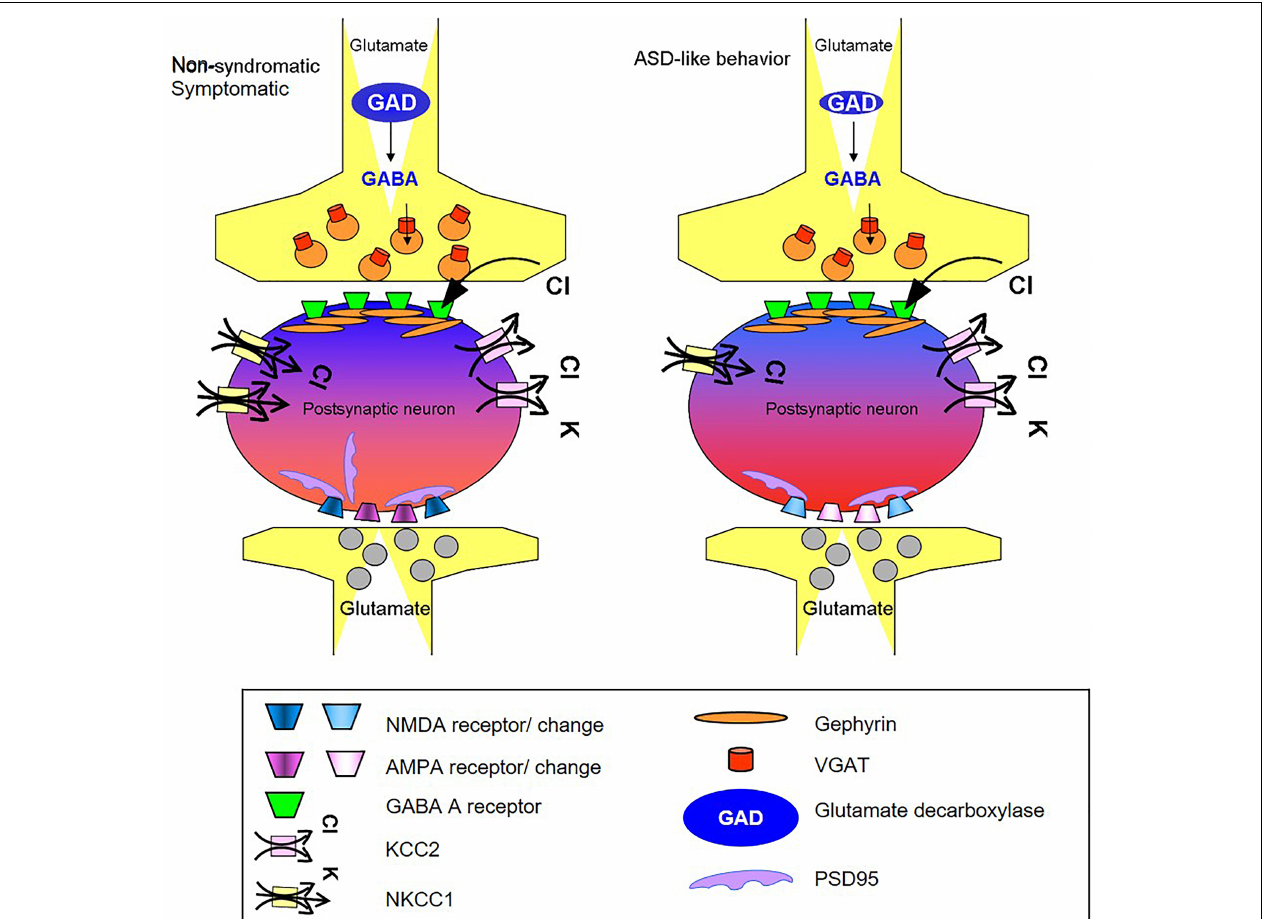
FIGURE 5 | Schematic summary of changes in GABA and glutamate synapse components obtained in the cortex of mice presenting the ASD-like phenotype. The illustration shows the possible molecular origin of the neuronal perturbation that leads to ASD-like behavior in Mthfr deficient mice. The cellular consequences of the changes in GABAergic and glutamatergic proteins observed in the current study: the GABAergic pre-synapse in the ASD-like cortex contains a lower number of vesicular GABA transporters (red) and lower levels of GAD (blue) compared to non-symptomatic cortex. The post-synapse site in the neuron of the ASD-like cortex contains a lower number of NKCC1 transporters (yellow), and thus, GABA receptor (green) activation may result in a less hyperpolarized potential compared to the non- symptomatic cortex (represented by lighter blue color of the neuron in the GABAergic synapse region). The glutamatergic synapse in the cortex of ASD-like mice had a smaller number of PSD-95 molecules (purple). Furthermore, the subunit compositions of the AMPA (purple) and NMDA (blue) receptors in these mice differed from those in the non-symptomatic mice, represented in the figure by the different colors of the receptors. AMPA and NMDA were affected in a sex dependent manner that is not represented in the